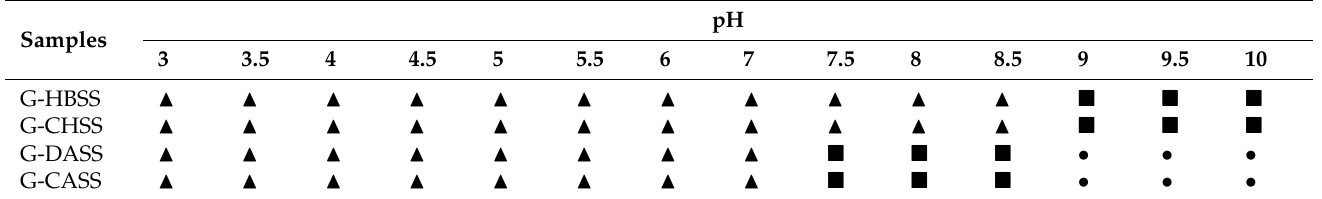
Table 1. State diagrams of G-MLPs’ mixed solutions (1 mg/mL) as a function of pH. Samples